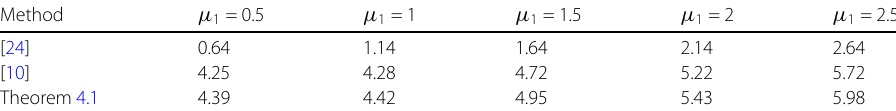
Table 4 Maximum value of μ 2 for different values of μ 1 ( η 1 = 0.25, η 2 = 0.5) Method μ 1 =